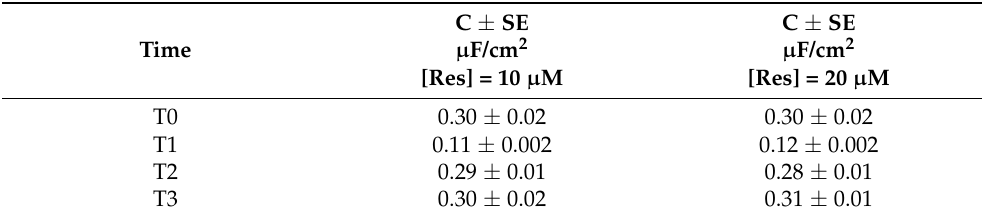
Table 4. Capacitance variation in POPC:Ch PLM. Mean values of the membrane capacitance (C ± SE) calculated at T0, T1, T2, and T3, for which meanings are reported in the legend to Table 3. The mean value was obtained from at least four